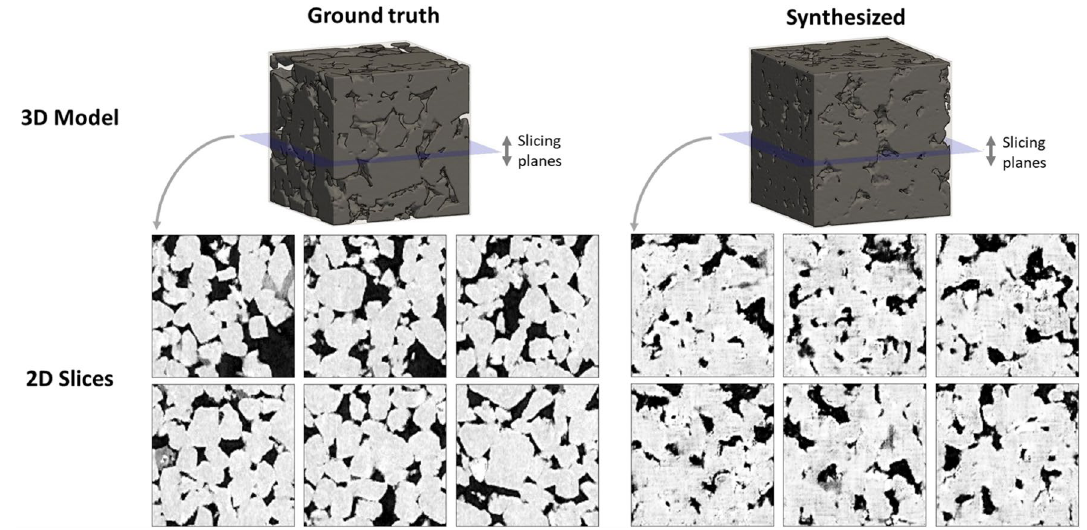
Figure 4. Comparison of 2D slices and 3D volume renders of ground truth microstructures and GAN- generated microstructures. In terms of the visual quality, the synthetic microstructures look realistic such that it is difficult to distinguish between the real and synthetic microstructures. Futher, the synthetic voids and crystals also look realistic and diverse.